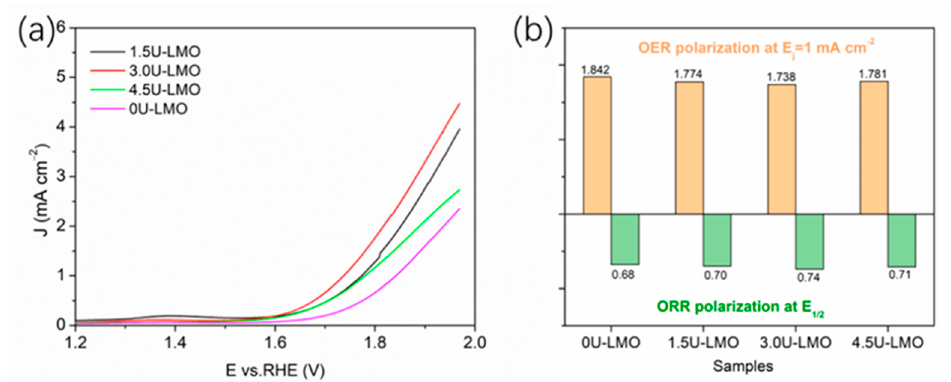
Figure 7. ( a ) OER properties over xU-LMO (x = 0, 1.5, 3.0, and 4.5) catalysts in 0.1 M KOH solution and ( b ) the potential difference ( Δ E) between E j = 1 mA cm − 2 (OER) and E 1/2 (ORR) of xU-LMO (x = 0, 1.5, 3.0, and 4.5) catalysts.